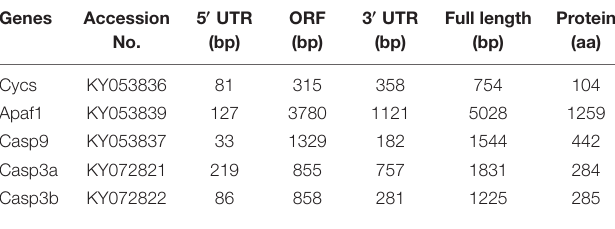
TABLE 1 | The sequence information of five apoptosis related genes from P.